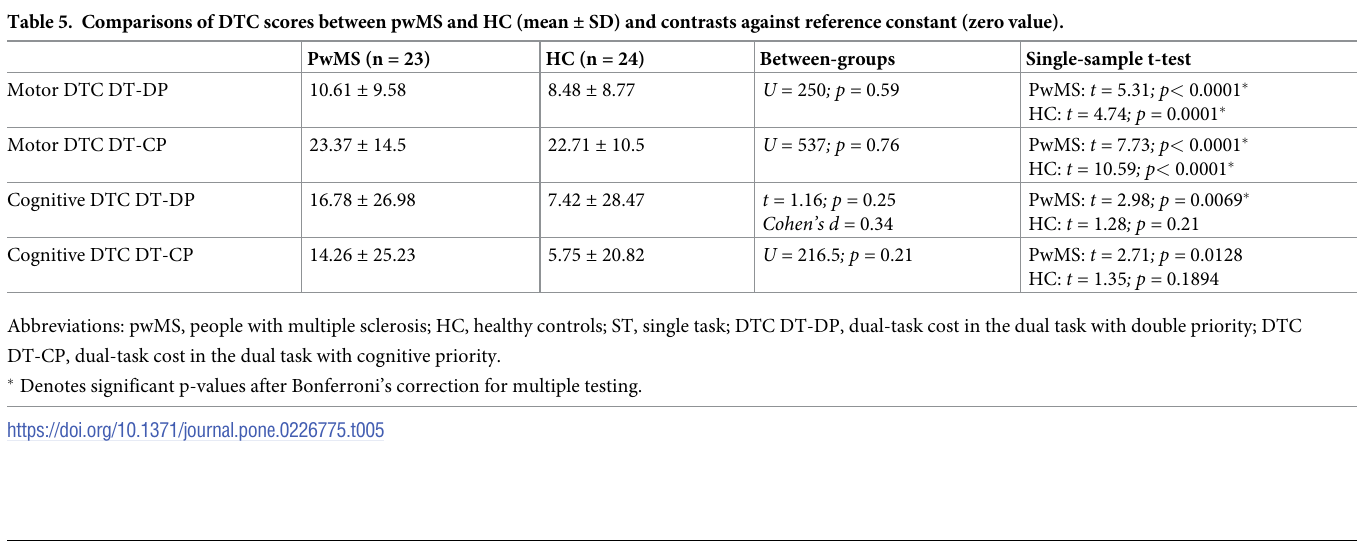
the more flexibility (lower score), the better motor and cognitive performance in DT (more walked distance and more correct words uttered) in pwMS. No significant correlations were found between FDT-Flexibility and direct DT scores in HC, nor between FDT-inhibition and any DT parameters in any group ( p > 0.05 in all cases). In addition, there was a significant pos- itive correlation between the TAVEC-Immediate recall and all direct DT scores in pwMS ( p < 0.05) except for the distance walked in DT-CP ( p > 0.05), whereas the Long-delay free recall only correlated with the correct words in the three conditions (ST, DT-DP, DT-CP) ( p < 0.05). In the HC group, only the correct words uttered in ST and DT-CP significantly correlated with TAVEC-Immediate recall, Short-delay free recall and Long-delay free recall ( p < 0.05). DTC scores. Significant correlations were found only in HC between SDMT and cogni- tive DTC in DT-DP (rho = -0.44, p = 0.031) and between FDT-Inhibition with the cognitive DTC in DT-CP (rho = 0.45; p = 0.028). TAVEC- Long-delay free recall showed a significant negative correlation with the cognitive DTC in DT-CP in both groups (pwMS: rho = -0.48, p = 0.022; HC: rho = 0.74, p < 0.001) (see S1 Table).